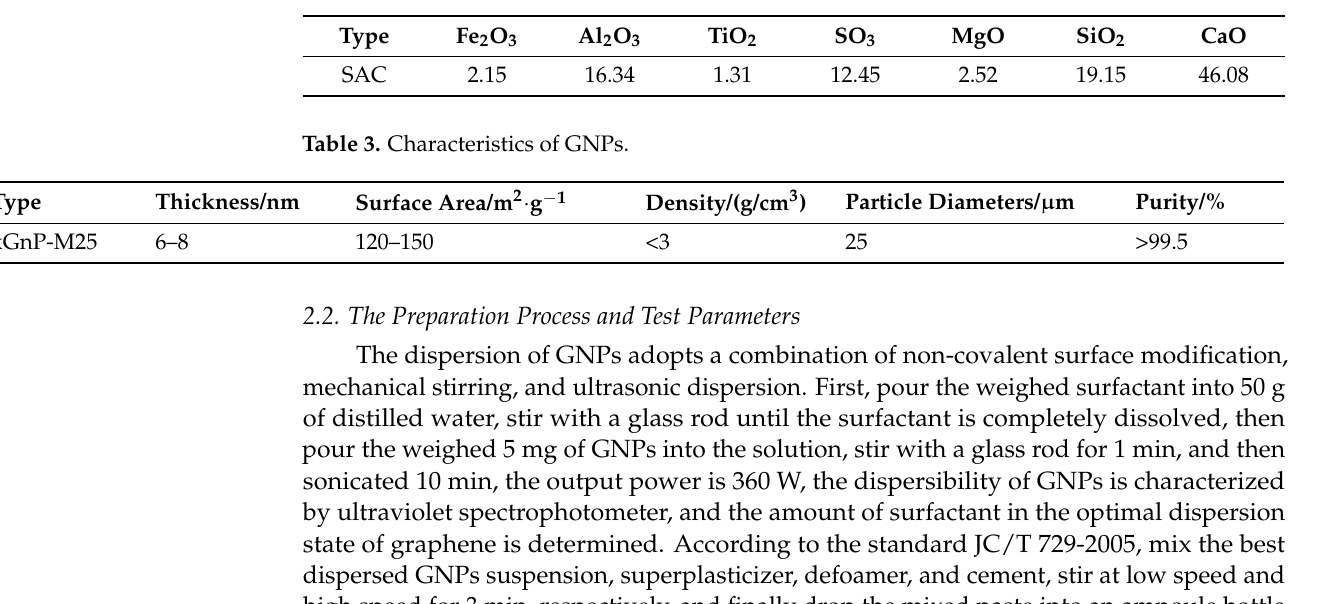
Table 2. Chemical compositions of SAC (wt%).